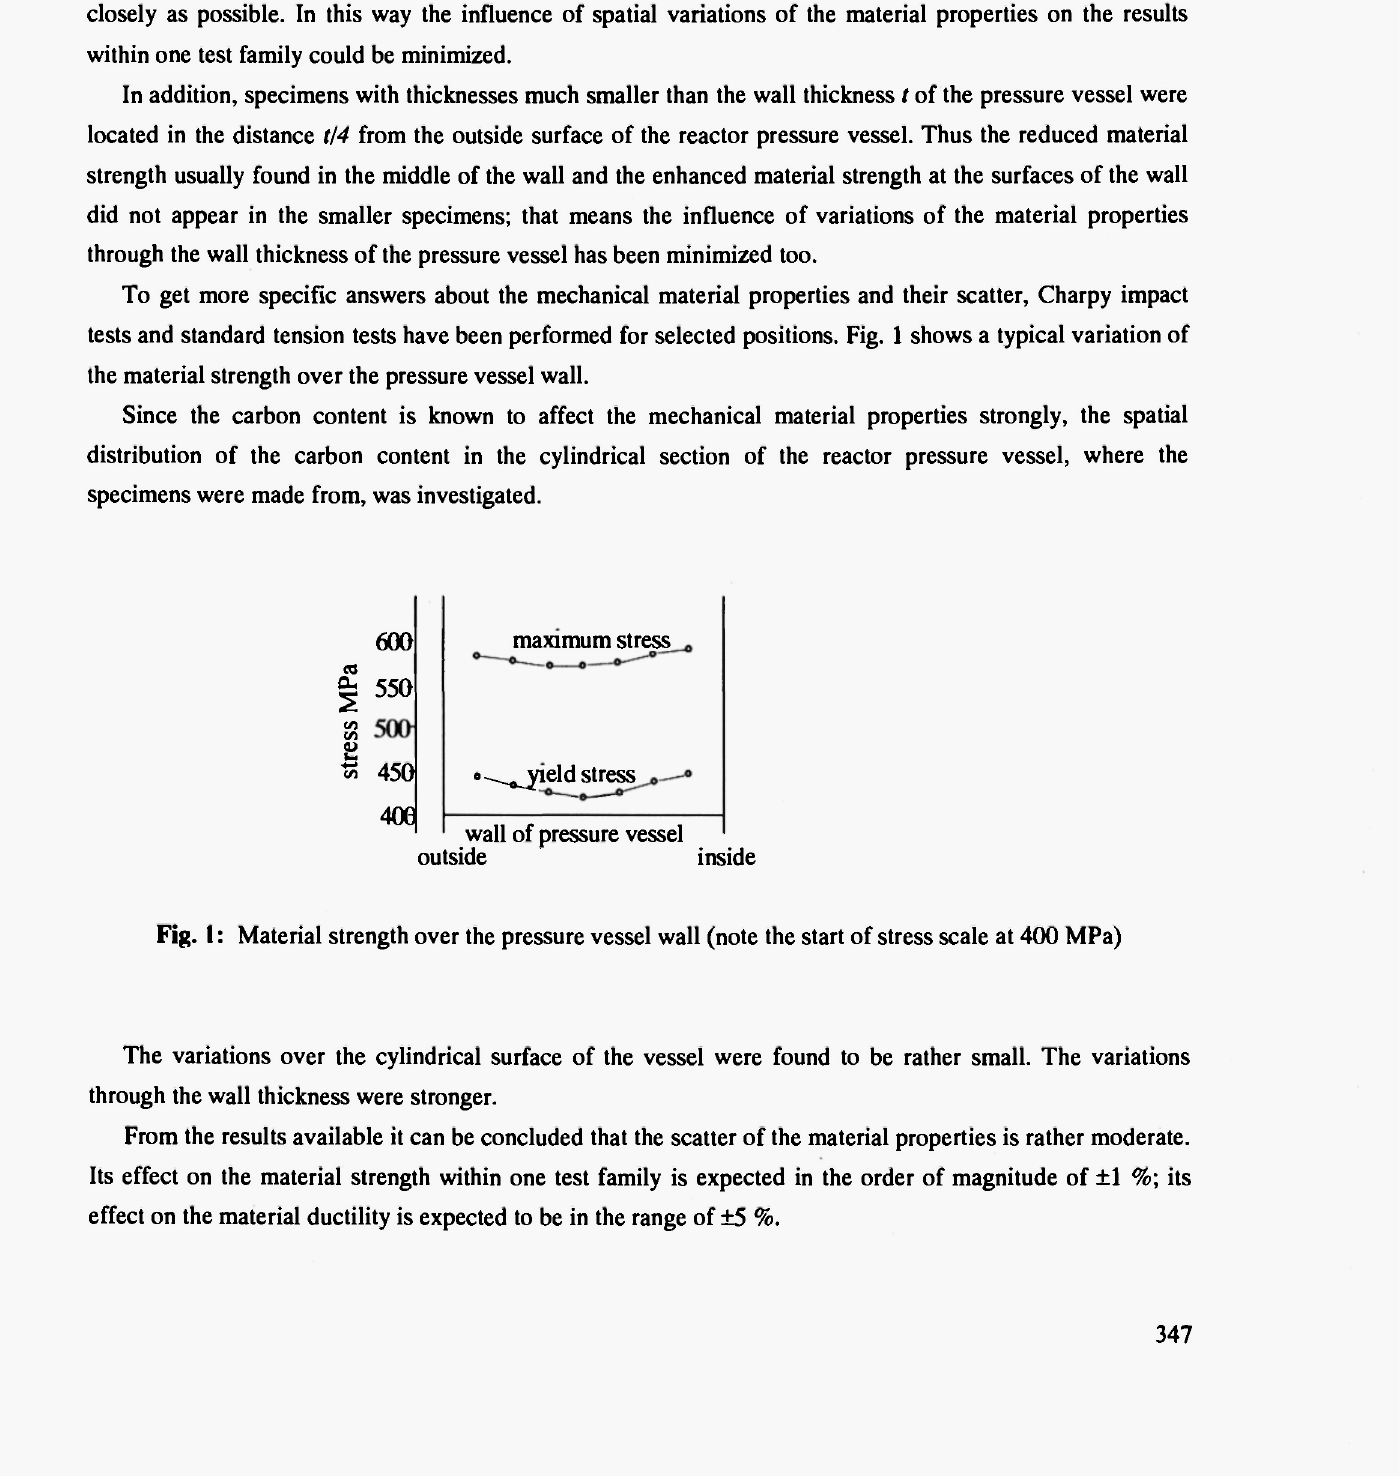
The variations over the cylindrical surface of the vessel were found to be rather small. The variations through the wall thickness were